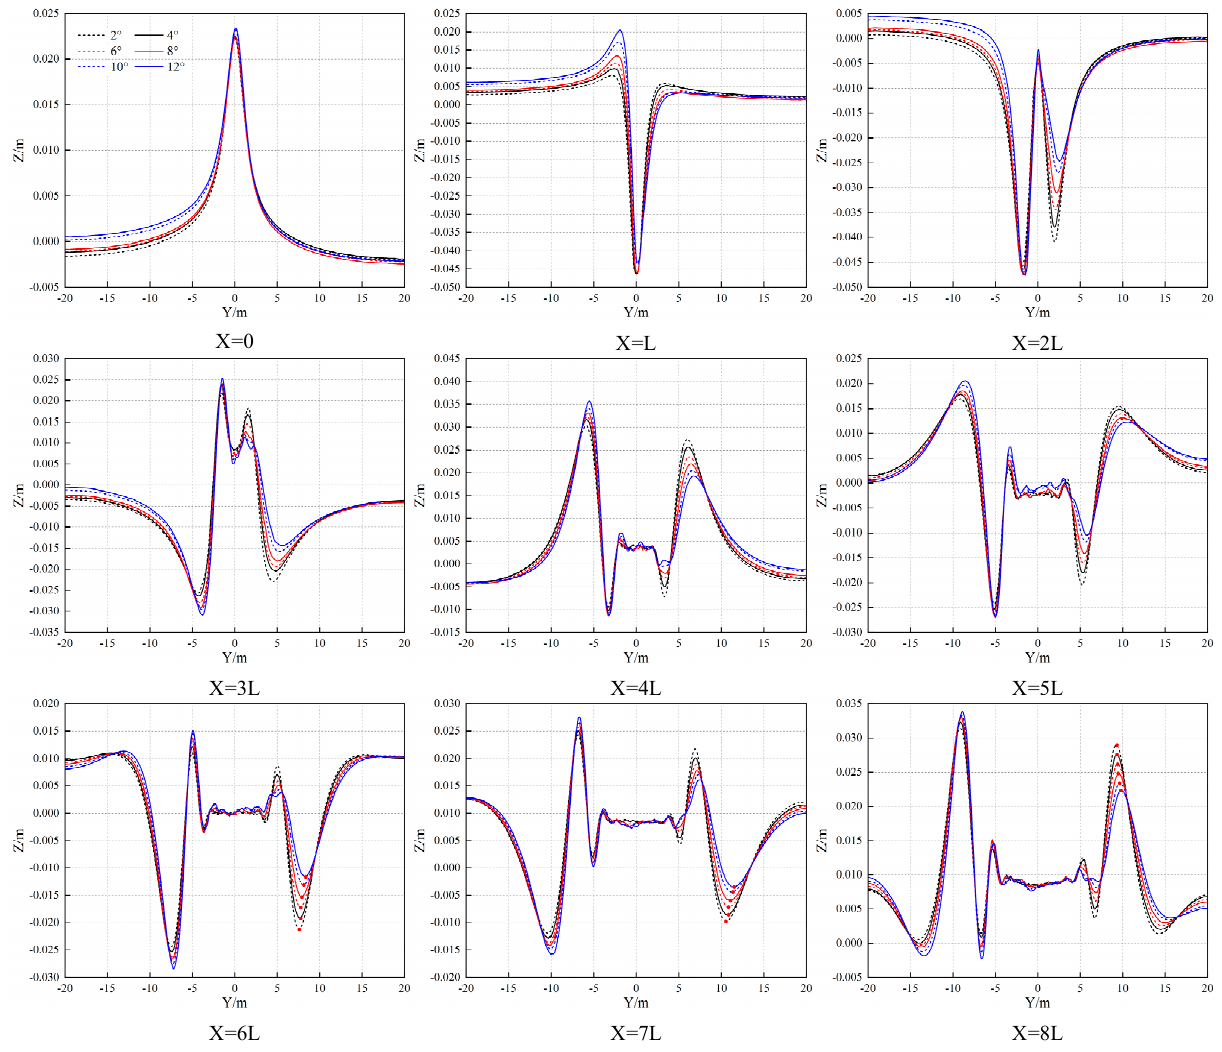
Figure 14. Comparison of transverse wave cutting at different drift angles and different positions.